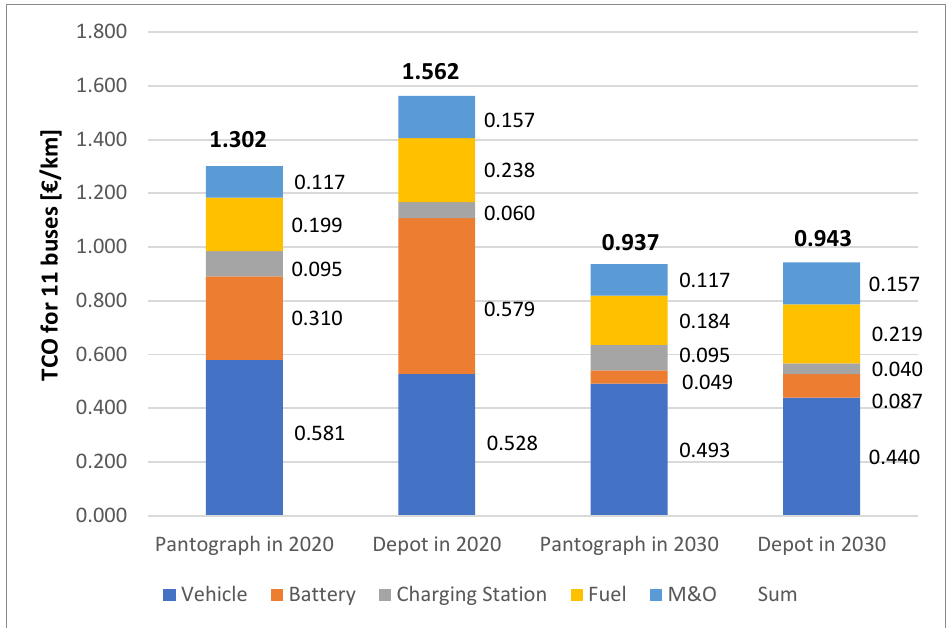
Figure 12. Battery electric bus TCO results for 11 buses scenario with two charging methods.